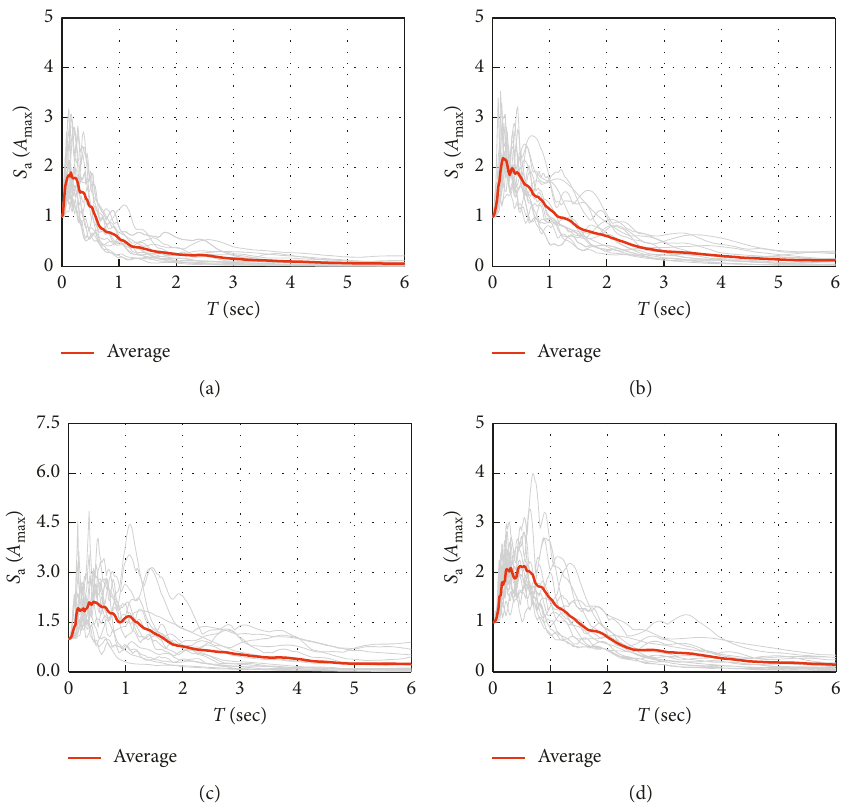
Figure 7: Acceleration response spectra of the horizontal component. (a) Site I. (b) Site II. (c) Site III. (d) Site